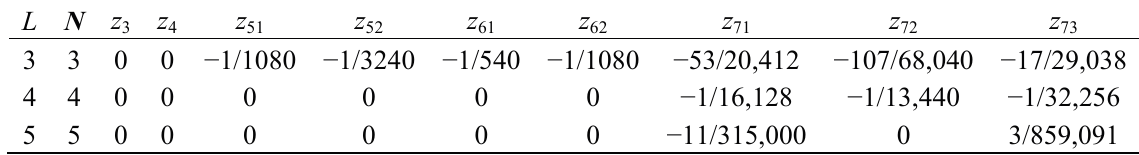
Table 15. Main attribution to maneuver error for FTSuc